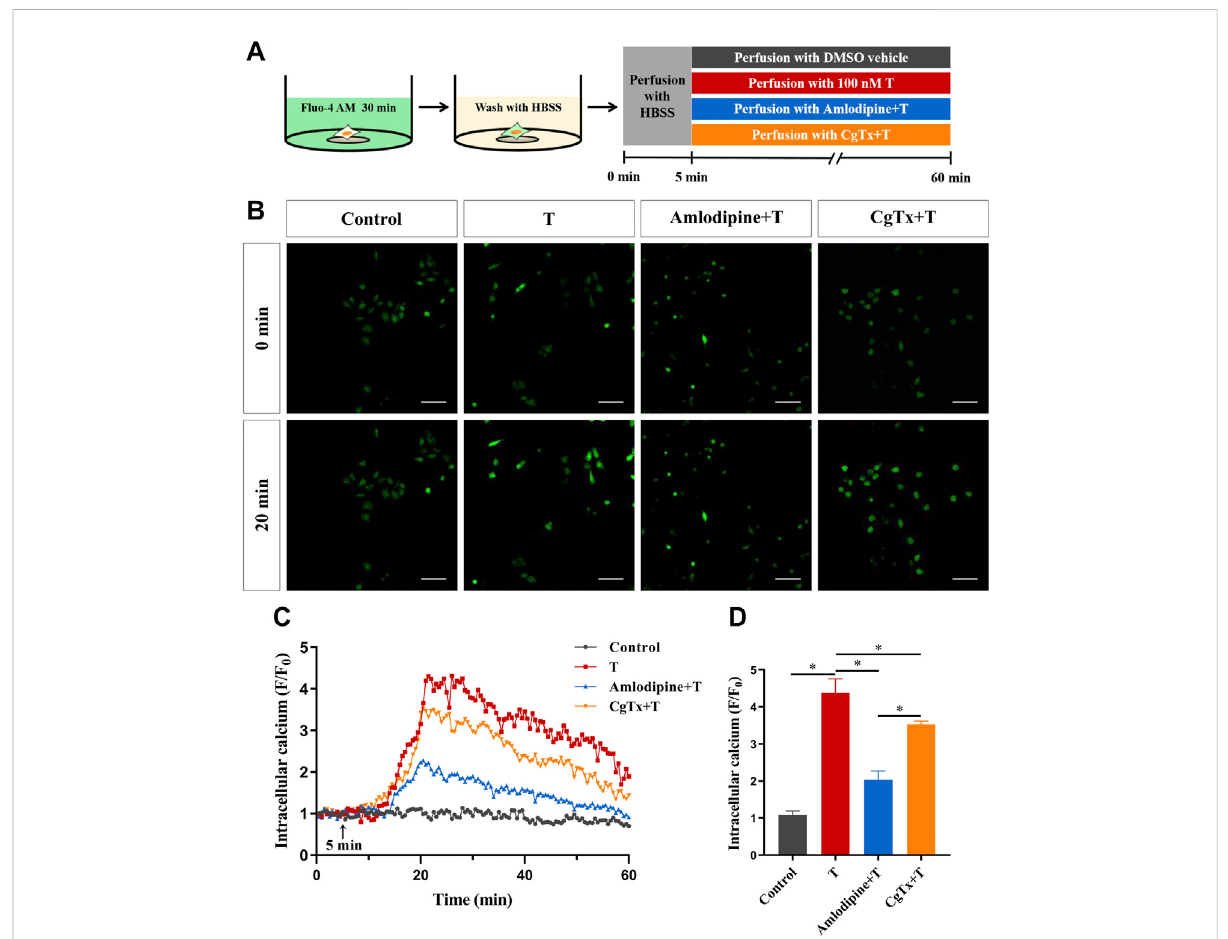
FIGURE 6 Voltage-gated calcium channels are involved in the T-induced increase of Ca 2+ in HT22 cells. (A) Schematic diagram of calcium imaging in the voltage-gated calcium channel experiment in HT22 cells labeled with Fluo-4AM. (B) Fluorescence images of the voltage-gated calcium channel experimentinFluo-4AM-labeledHT22cells.Scalebars=50 μ m. (C) RepresentativetracesshowingchangesinCa 2+ (F/F0)inducedbyTinHT22cells treated with amlodipine and CgTx. The black arrow indicates when the HT22 cells were treated. (D) Statistical graph showing the T-induced changes in Ca 2+ (F/F0) in HT22 cells treated with amlodipine and CgTx (ns: non-signi fi cant; * p <